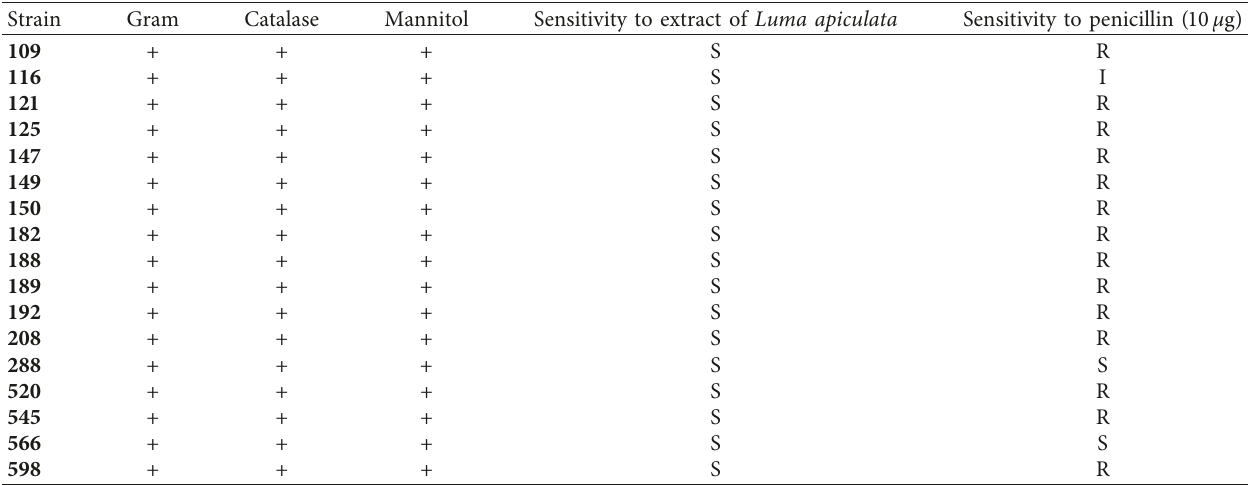
Sensitivity: S (sensitive), R (resistant), and I Table 3 summarizes the results of antimicrobial effect of the hexane extract against S. aureus strains obtained from patients suffering palatine cleft lip. Moreover,